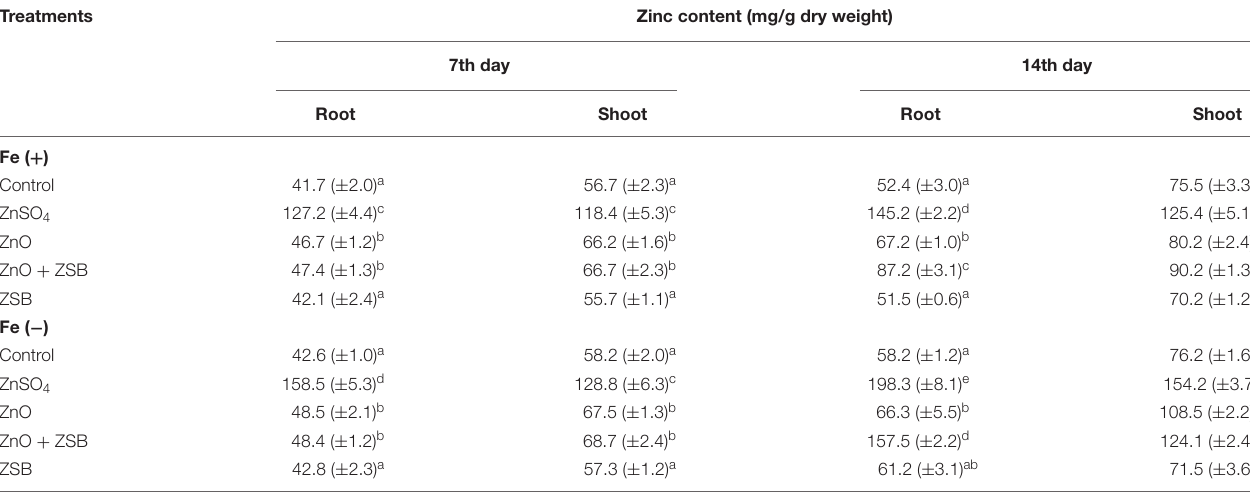
TABLE 2 | Effect of different Zn sources and ZSB inoculation on the Zn content of rice seedlings (Cultivar Co51).